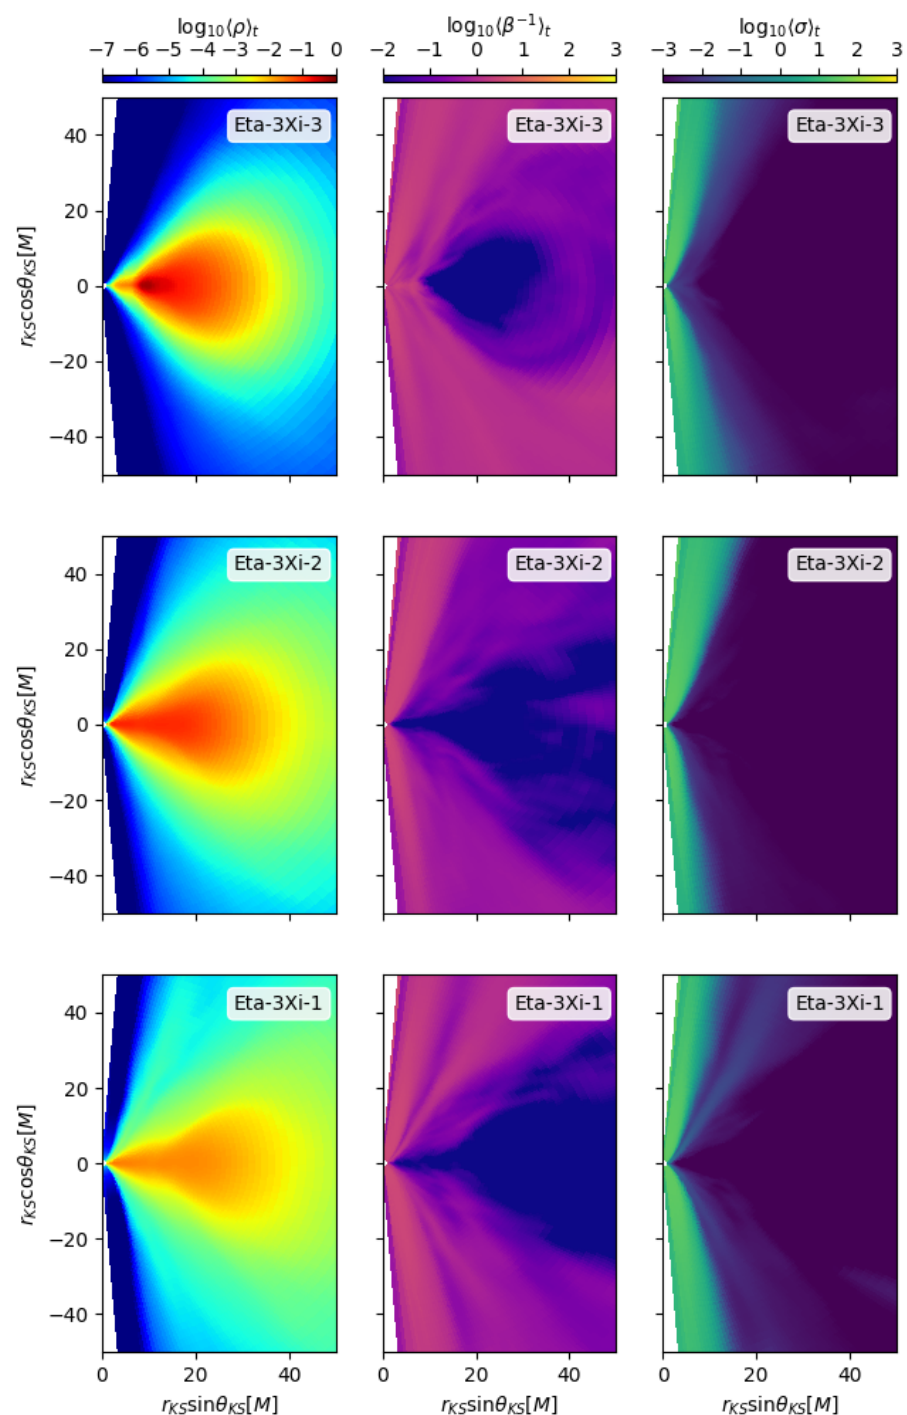
Figure 5. Time-averaged data for rest-mass density, inverse plasma β , and magnetization for runs with η 0 = 10 − 3 . We indicate with (cid:104)·(cid:105) t the time average in the range [5000 M ,10,000 M